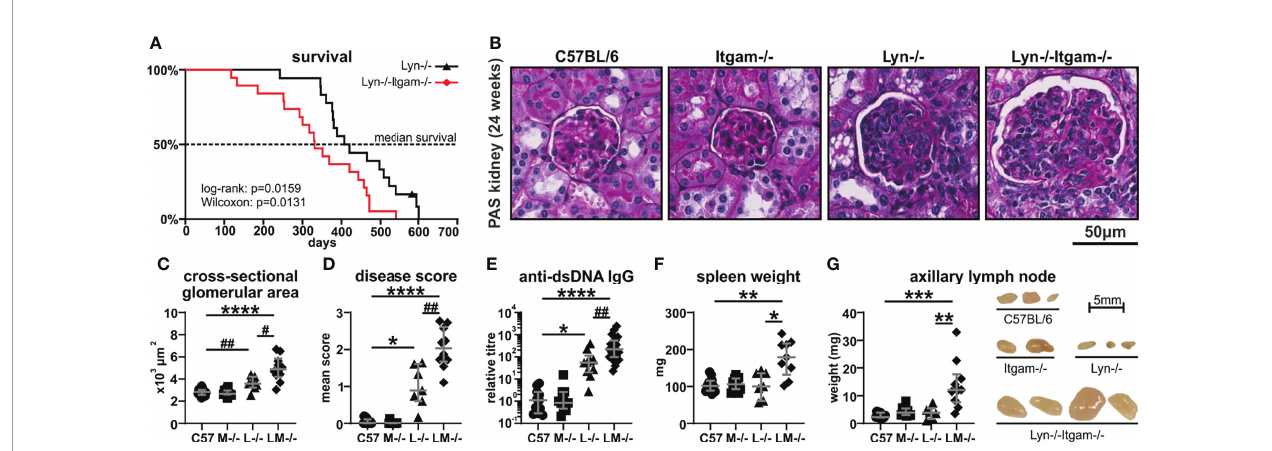
FIGURE 2 | Lyn -/- Itgam -/- mice exhibit enhanced systemic autoimmune disease. (A) Survival of Lyn -/- and Lyn -/- Itgam -/- mice by Kaplan-Meier survival analyses. The indicated 24-week-old mice were evaluated for: (B) glomerular histopathology by PAS staining with quantitation of (C) glomerular cross-sectional area and (D) mean disease score; (E) anti-dsDNA IgG autoantibodies; (F) spleen weight and (G) axillary lymph node weight and size. For (A) , n = 18-19 per group, signi fi cance determined by log-rank and Wilcoxon tests. Data in (C, D, F ,G) are of n = 7-12 per group pooled from three experiments and data in (E) are of n = 10-21 per group. Images in (B, G) are representative of three experiments. *p < 0.05, **p < 0.01, ***p < 0.001, ****p < 0.0001 by Dunn ’ s multiple comparisons test and # p < 0.05, ## p < 0.01 by Mann-Whitney U